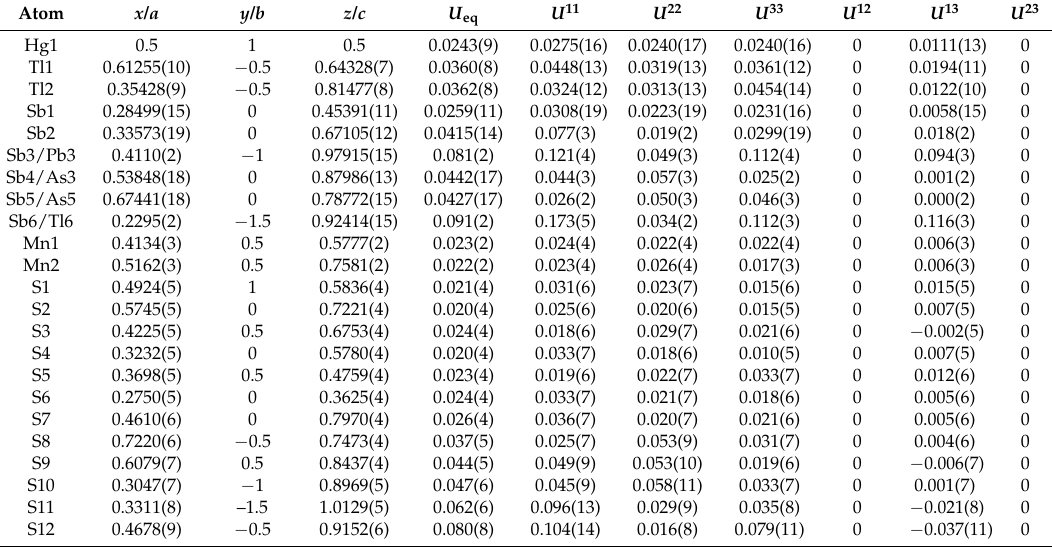
Table 5. Atom positions and displacement parameters (in Å 2 ) for tsygankoite.